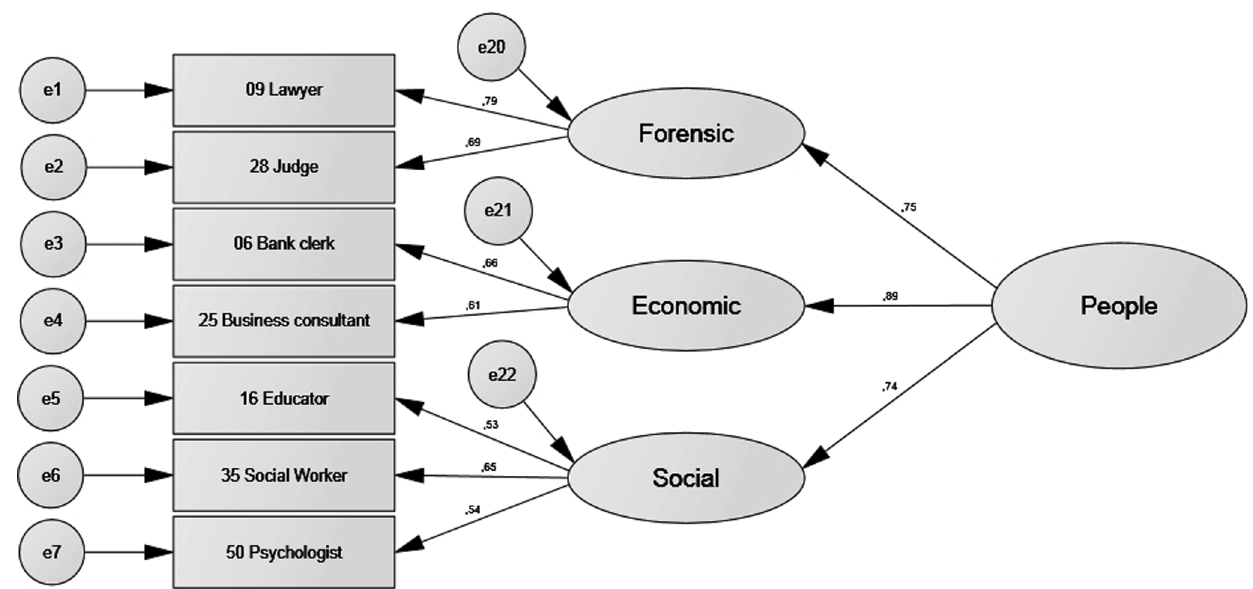
Figure 5. Standardised estimates for the people